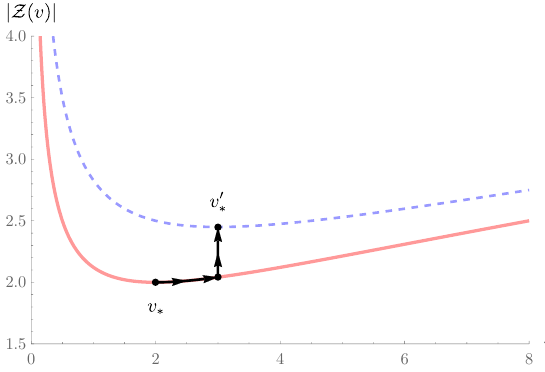
Figure 3 . The potential (7.21) for the choice of the constants e 1 = m 0 = 1, e 0 = m 1 = 2, k = 1 and keeping Re (cid:30) = 0. The solid red line refers to the potential on the left of the membrane, while the dashed blue line to that on the right. This potential exhibits, on the left of the membrane, a supersymmetric AdS critical point located at v (cid:3) = 2 and, on the right, a supersymmetric AdS critical point at v 0 = 3. (cid:3)